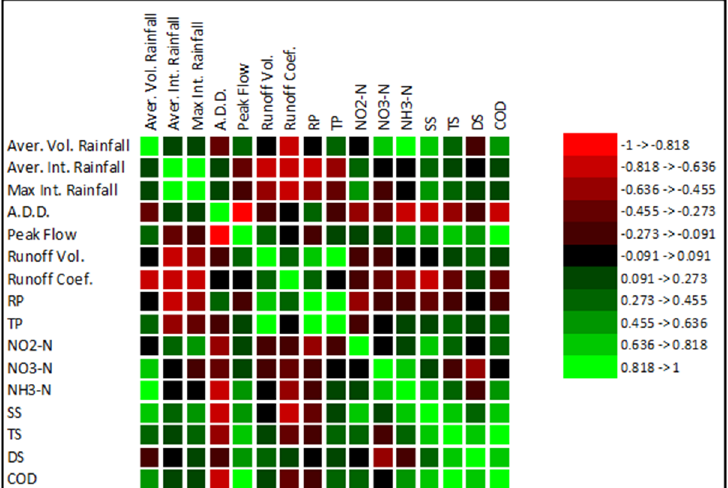
Figure 4. Correlation between the hydrological data and the water quality characteristics during floods.